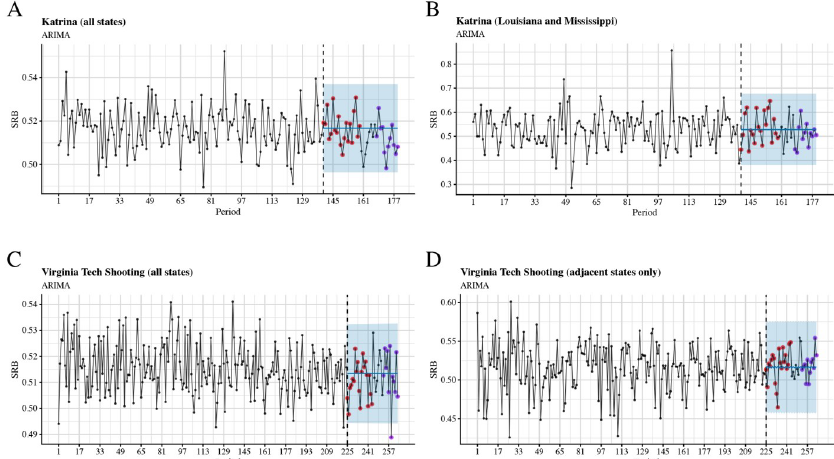
Fig 3. Time series plots and out-of-sample forecasts for SRB data grouped into 7-day periods and fitted with seasonal ARIMA models. The blue shade is the 95% confidence level. The observed SRBs for the first five months after the intervention are presented by red dots, whereas the observed SRBs for 7 to 9 months after the intervention are presented by purple dots. A: Hurricane Katrina, all states; B: Hurricane Katrina, Louisiana and Mississippi only; C: Virginia Tech shooting, all states; D: Virginia Tech shooting, adjacent states